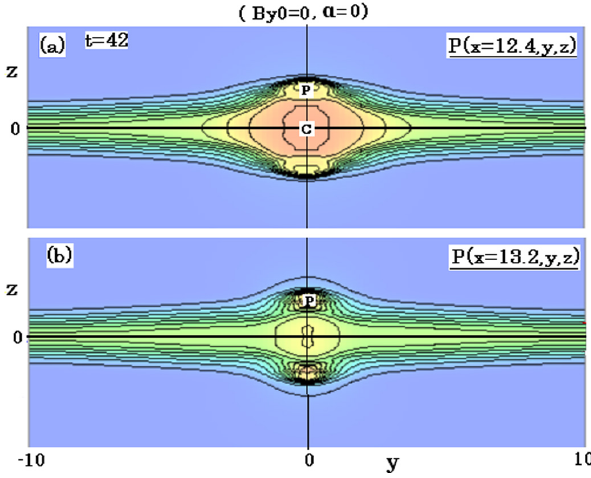
Fig. 3. Plasma pressure distributions with contour interval of 0 . 15 at t = 42 for the case of B y0 = α = 0 in the cross sections at (a) x = 12 . 4 and (b) x = 13 . 2, where the regions P and C are indicated.